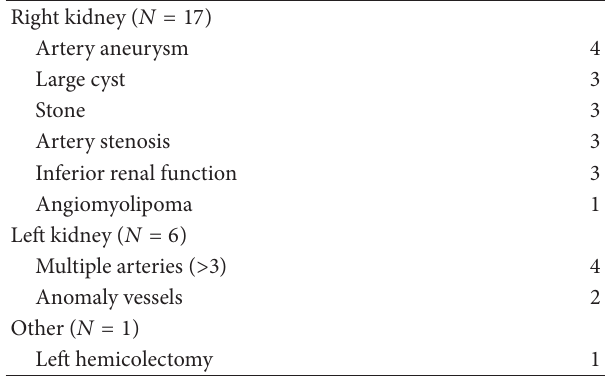
Table 1: Reasons for selection of right